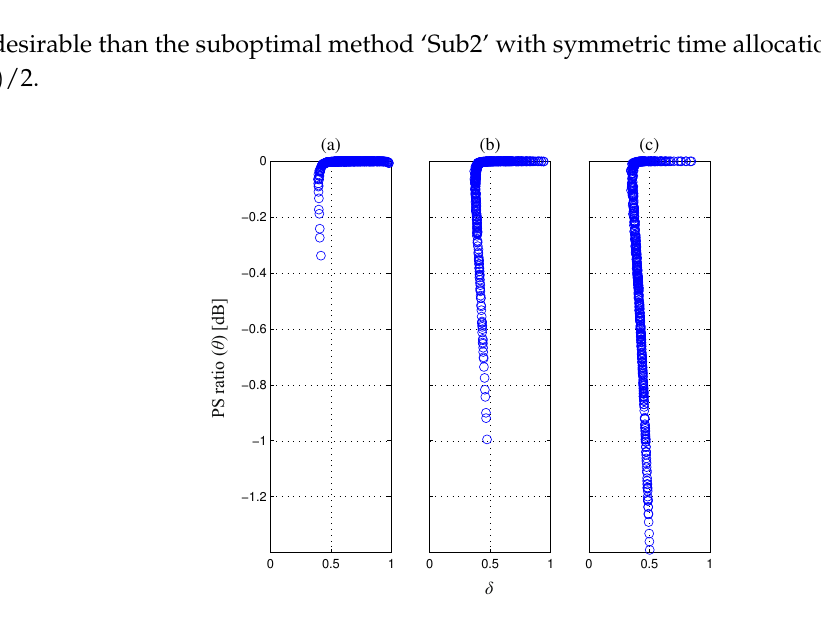
Figure 2. Optimized TP and PS ratios for the PS-SWIPT: ( a ) P = 10 dBm, ( b ) P = 20 dBm, ( c ) P = 30 dBm.